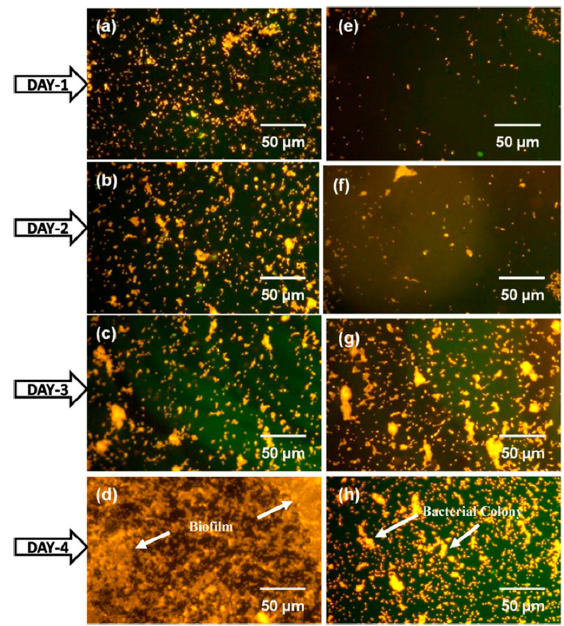
Figure 6. Epifluorescence microscopy analysis of P. aeruginosa bacterial invasion on 316L SS ( a – d ) and ZrO 2 film ( e – h ) after 1, 2, 3, and 4 days incubation [288]. The used acridine orange staining shows orange color for live cells and green color for dead cells. The reduction in bacterial adhesion was seen on ZrO 2 coated substrate compared to uncoated 316L SS.